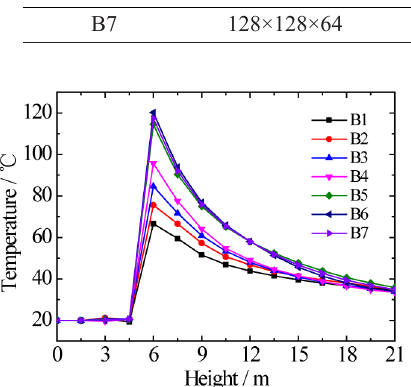
Fig. 4. Vertical temperature at the steady state next to the inner pane